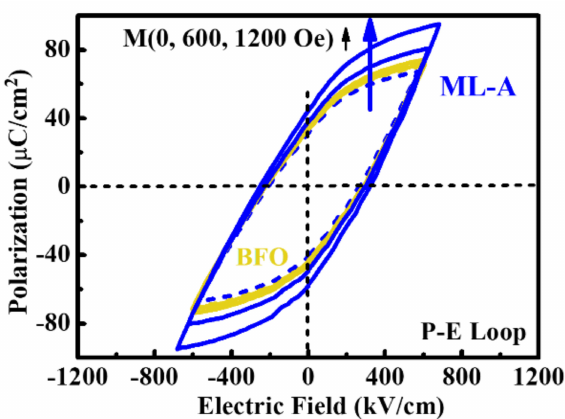
Figure 5. The plot of P-E for the pure 100 nm BiFeO 3 (BFO) and our designed multi-layer (BaTiO 3 (BTO)/BiFeO 3 (BFO)) structures for Condition A (ML-A) with different Magnetic (M)